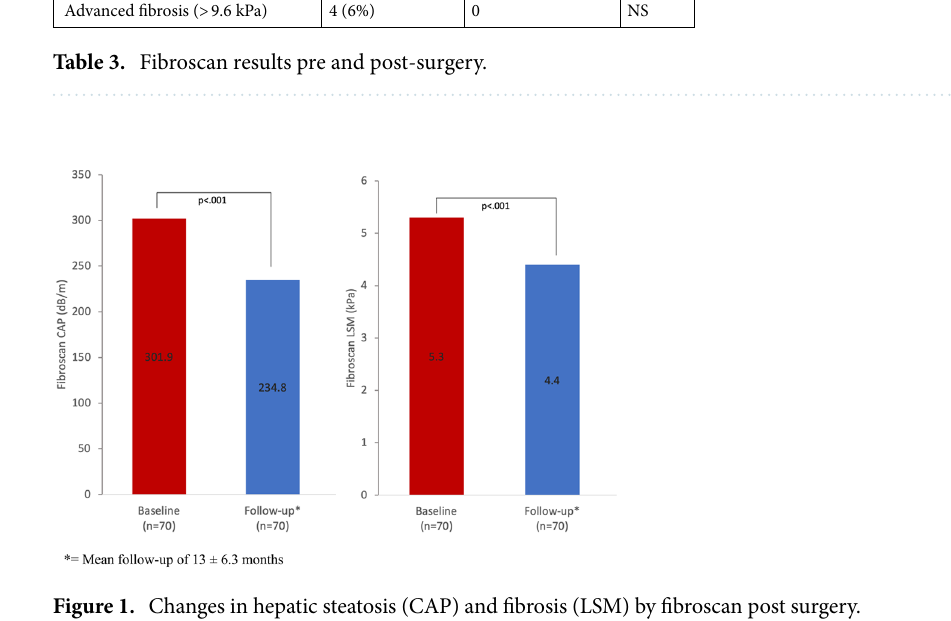
Figure 1. Changes in hepatic steatosis (CAP) and fibrosis (LSM) by fibroscan post surgery.